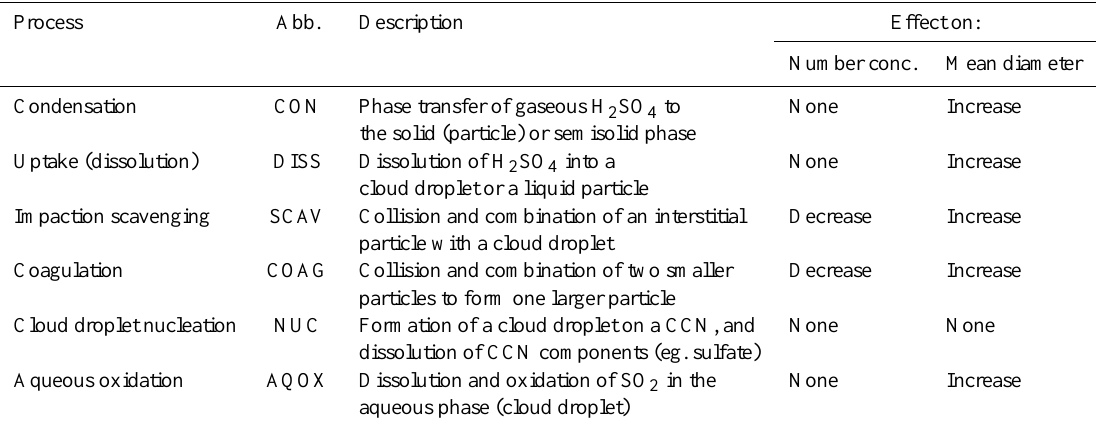
Table 1. Definitions and abbreviations (“Abb.”) for processes involving modification of particulate by sulfur species observed at HCCT-2010, after Seinfeld and Pandis (1998), p. 933. For in-cloud processes, effects on number concentration and mean diameter refer to the effect on the particle population following evaporation after an air particle leaves the cloud, i.e. downwind vs. upwind of a cloud. Processes CON, DISS, COAG and SCAV collectively involve direct transfer of sulfate from the gas-phase and ultrafine particle into a larger particle mode, and will be referred to as “direct uptake”, which can occur both in and out of a cloud. Process Abb. Description Effect on: Number conc. Mean diameter None